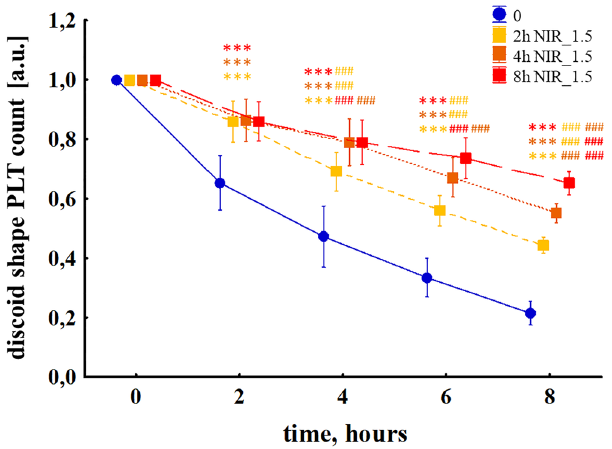
Figure 5. Change in the discoid shape PLT number subjected to NIR PBM with an irradiance of 1.5 mW/cm 2 (NIR_1.5) applied for 2, 4, or 8 h. The MANOVA results for interaction, time and group were p < 0.001 in each case. The results are presented as mean values ± standard deviation. The asterisk (*) indicates the differences concerning the CTR group, and the hash (#) indicates the differences between the individual NIR doses at particular time points. The number of measurements n = 11. ***p < 0.001, ### p < 0.001.